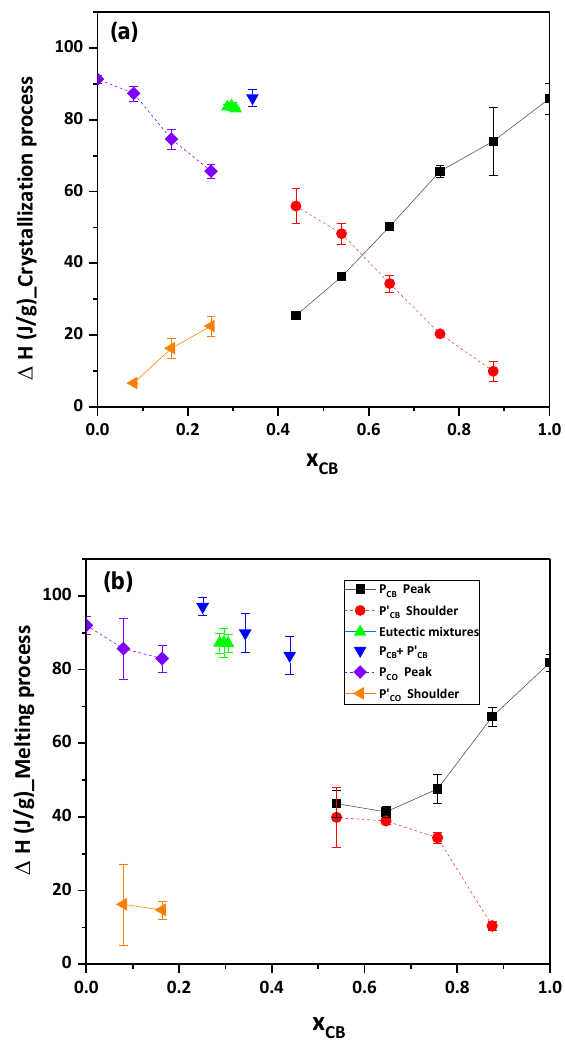
Figure 6. Enthalpy change of CB and CO during the crystallization ( a ) and remelting ( b ) process with respect to weight % of CB. black closed square = P CB , red closed circle = P’ CB , green closed triangles = eutectic mixtures (X CB = 0.36, 0.35, 0.34), blue closed reverse triangles = P CB +P’ CB, purple closed diamond = P CO , orange closed diamonds = P’ CO .